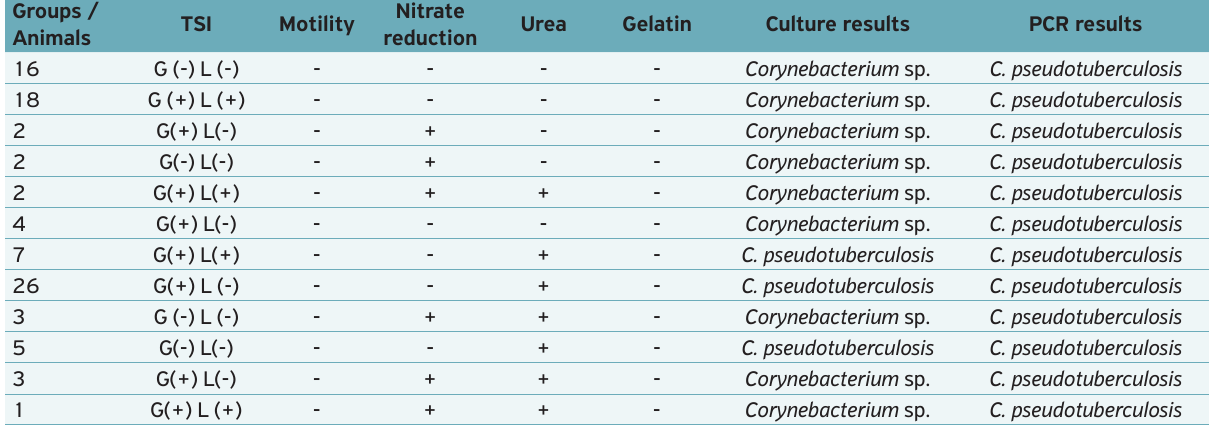
Table 2. Correlation between biochemical profiles and PCR in colonies isolated from clinical samples of sheep suspected of caseous lymphadenitis, Sao Paulo,